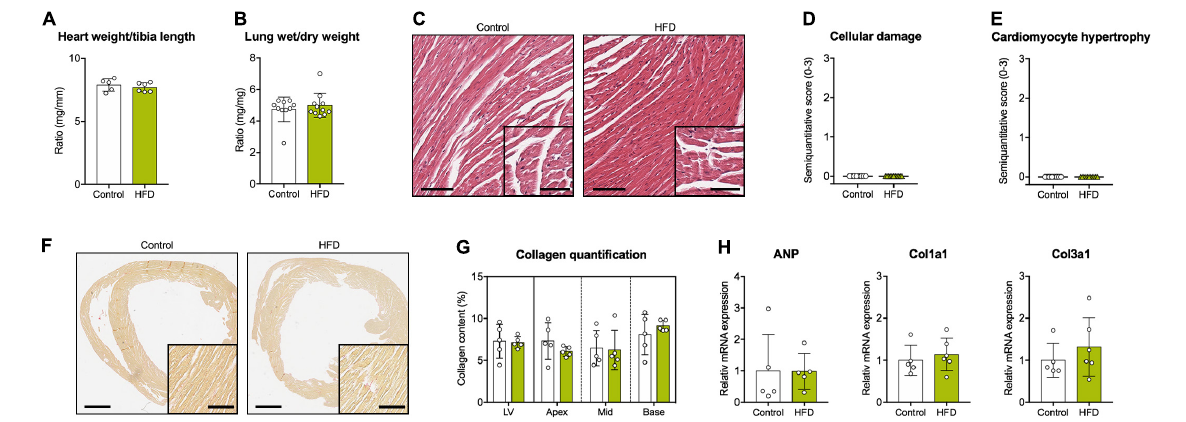
Frontiers in Cardiovascular Medicine |